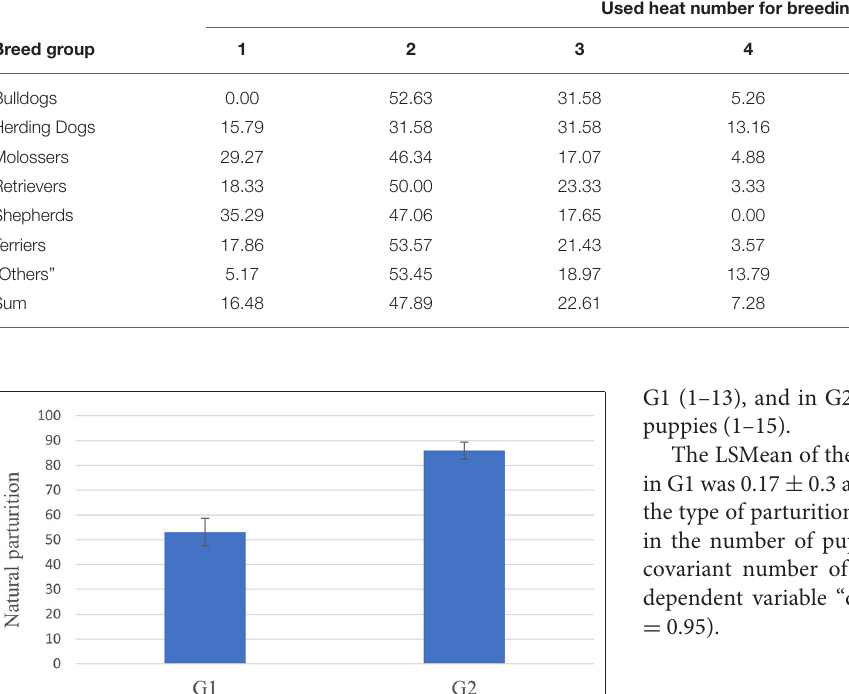
Used heat number for breeding